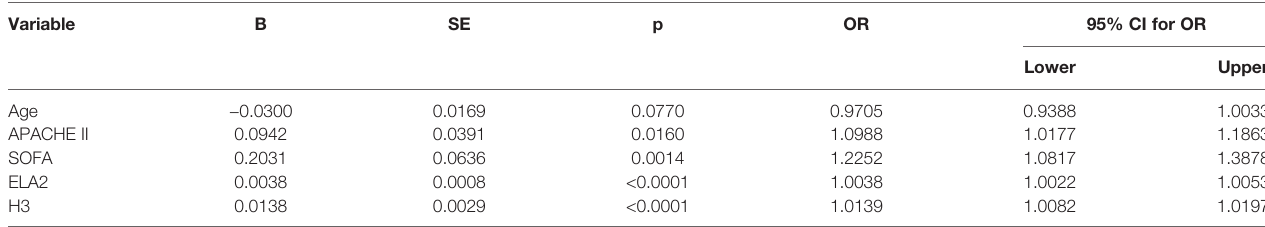
TABLE 3 | Univariate logistic regression analysis for possible risk factors for DIC.